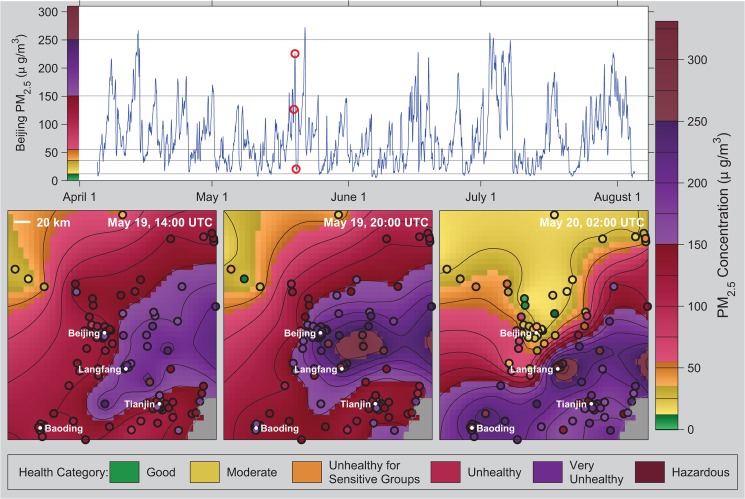
Time evolution of PM2.5 pollution in the vicinity of Beijing.(Top) Time series of PM2.5 concentration at Beijing extracted from the interpolated field. Red circles indicate times shown in bottom row. (Bottom) Maps of interpolated PM2.5 concentration during a period of high pollution. Pollution concentrations were computed as described in the text from hourly data and maps were rendered in MATLAB. Concentrations are shown using color gradients and contour lines, where color tones (green, yellow, etc.) correspond to health impact categories defined by the US EPA. Bold circles show station locations with the observed value at each station indicated by the color within the circle.